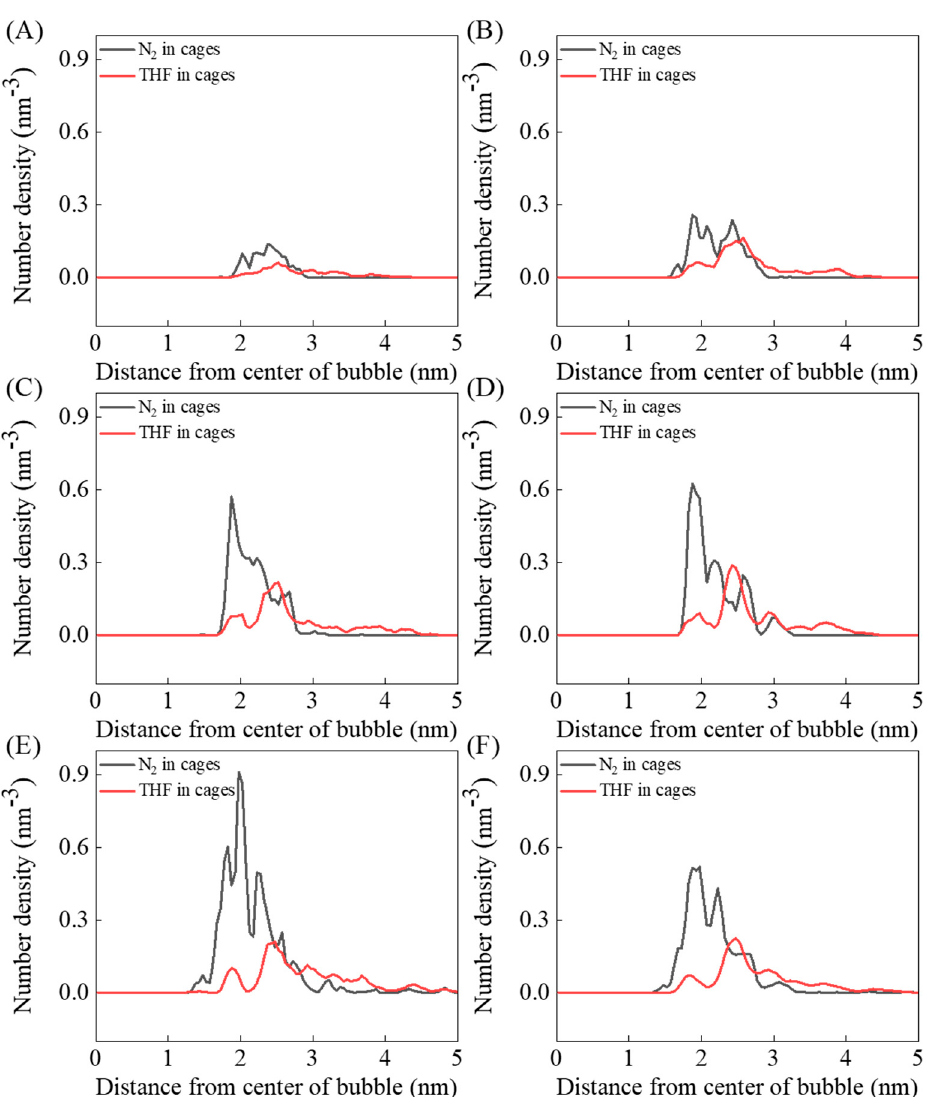
Figure 7. Distribution of caged N 2 and THF along the distance from center of bubble during ( A ) 0–